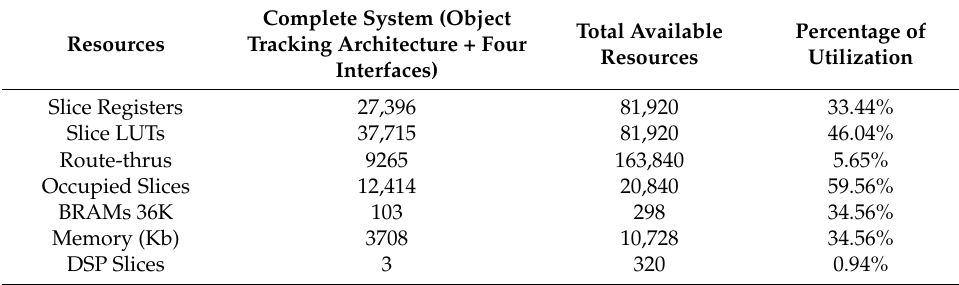
Table 2. FPGA resource utilization by complete implementation of object tracking